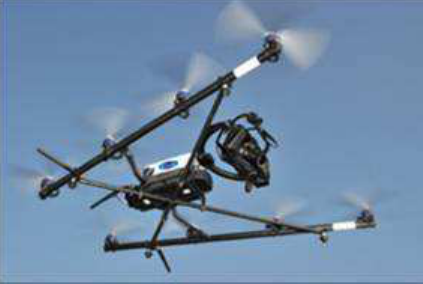
Figure 1. UAV of This Investigation